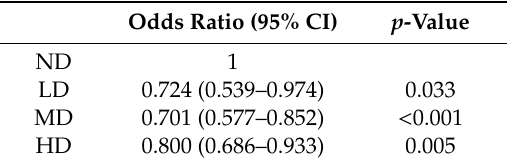
Table 3. Predictors of resistance to